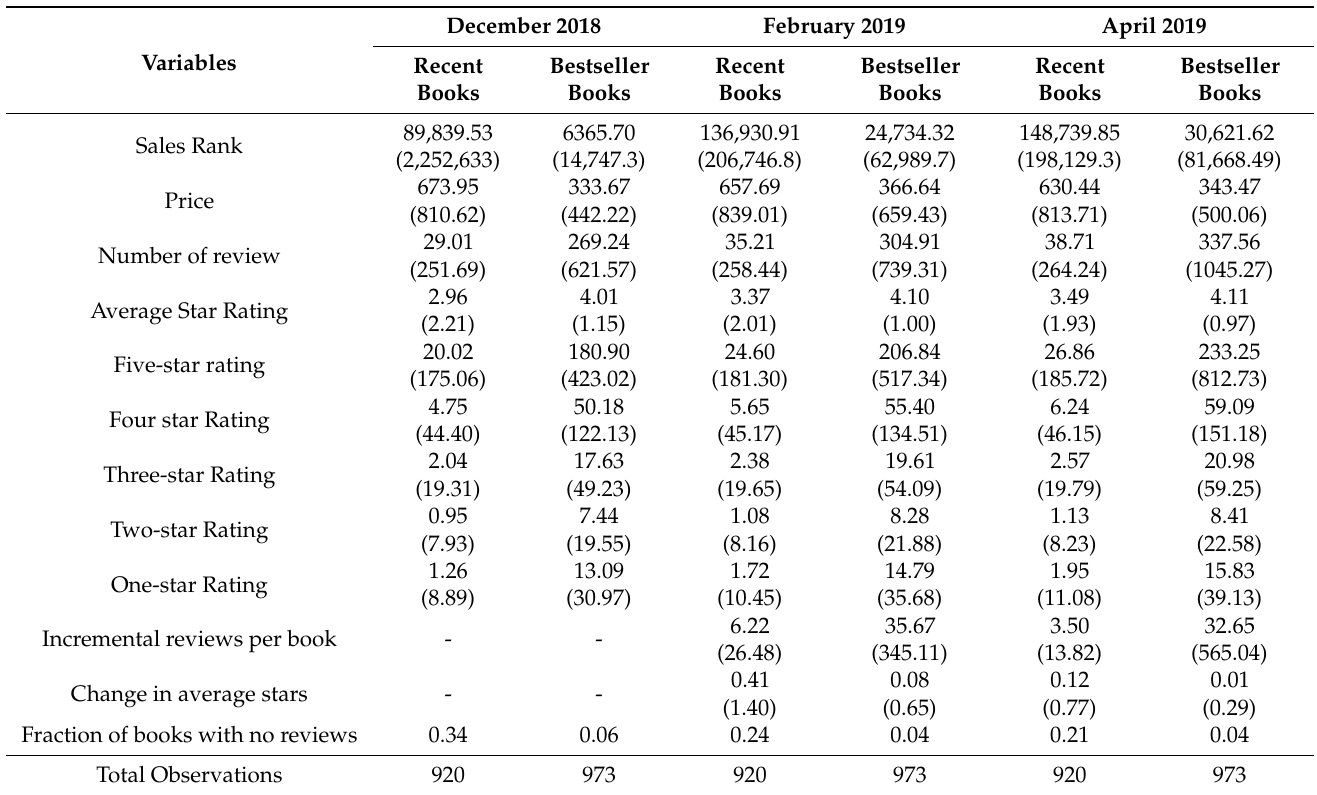
Table 1. Book Category-wise descriptive statistics (Mean and Standard